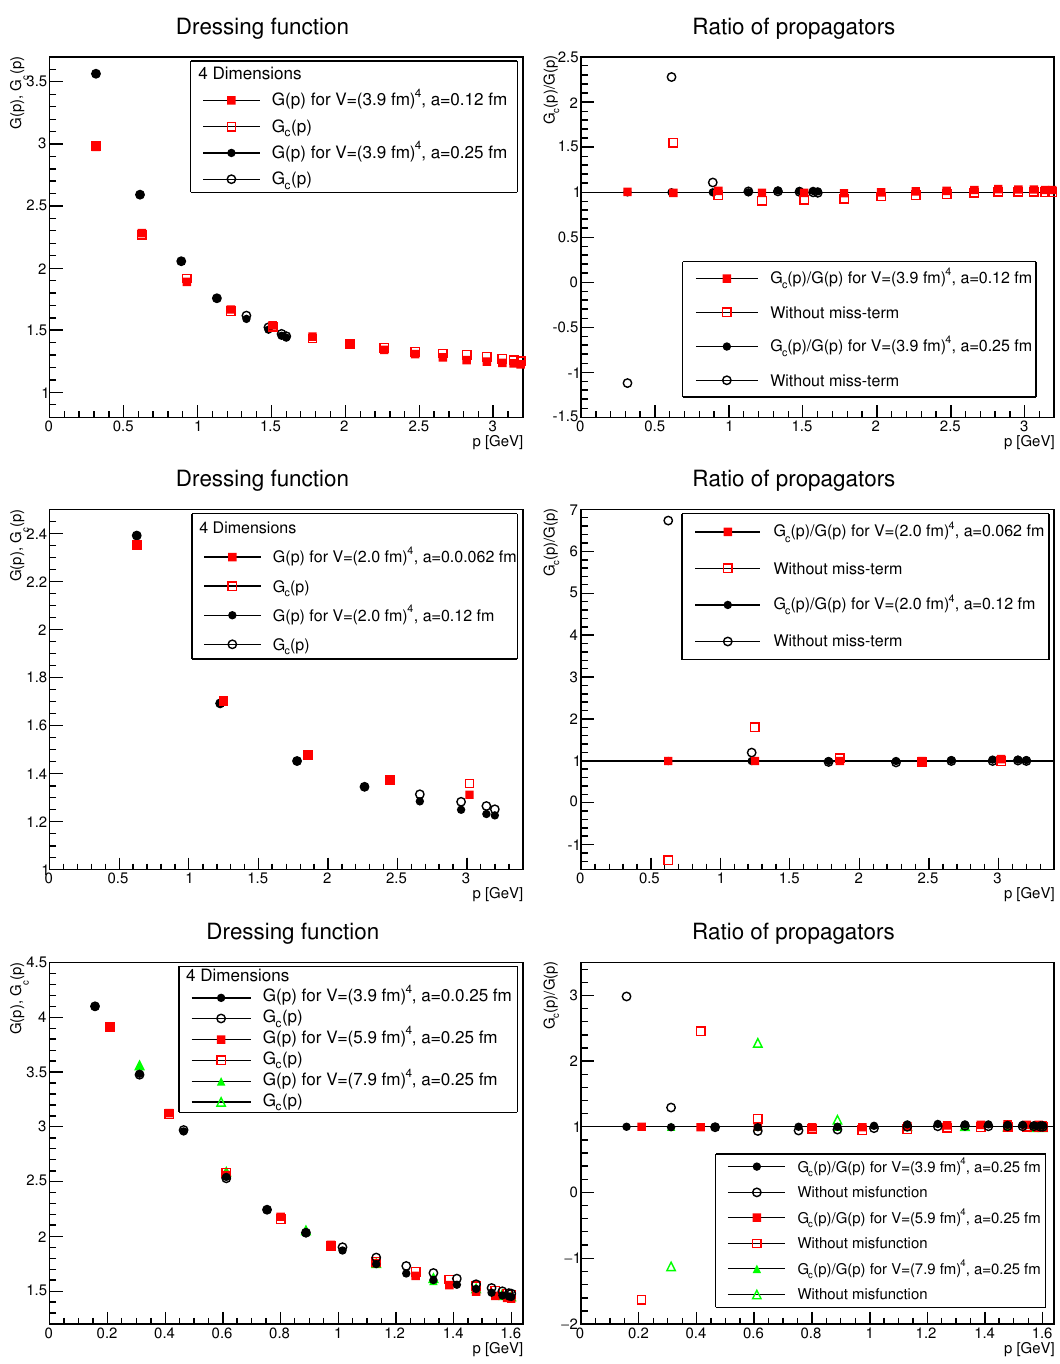
Figure 3: Same as figure 2, but in four